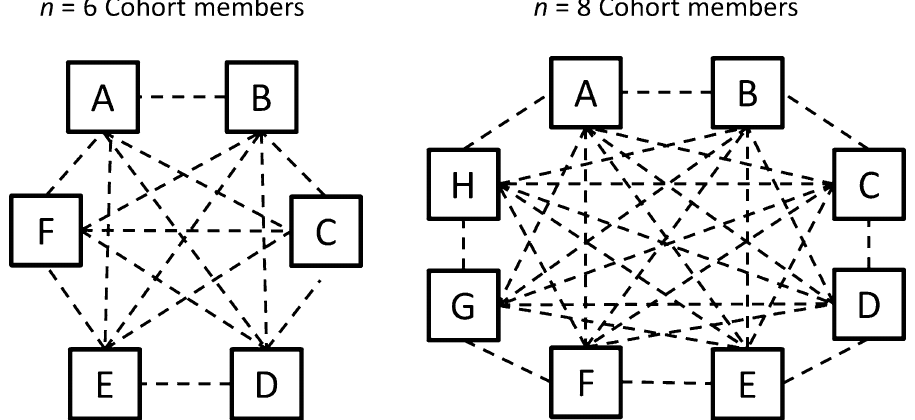
Figure 1. Dashed lines represent unique dyadic combinations in a cohort of six members (the minimum cohort size) and in a cohort of eight members (the maximum cohort size) during one session. Each dyadic combination has two linkage scores.